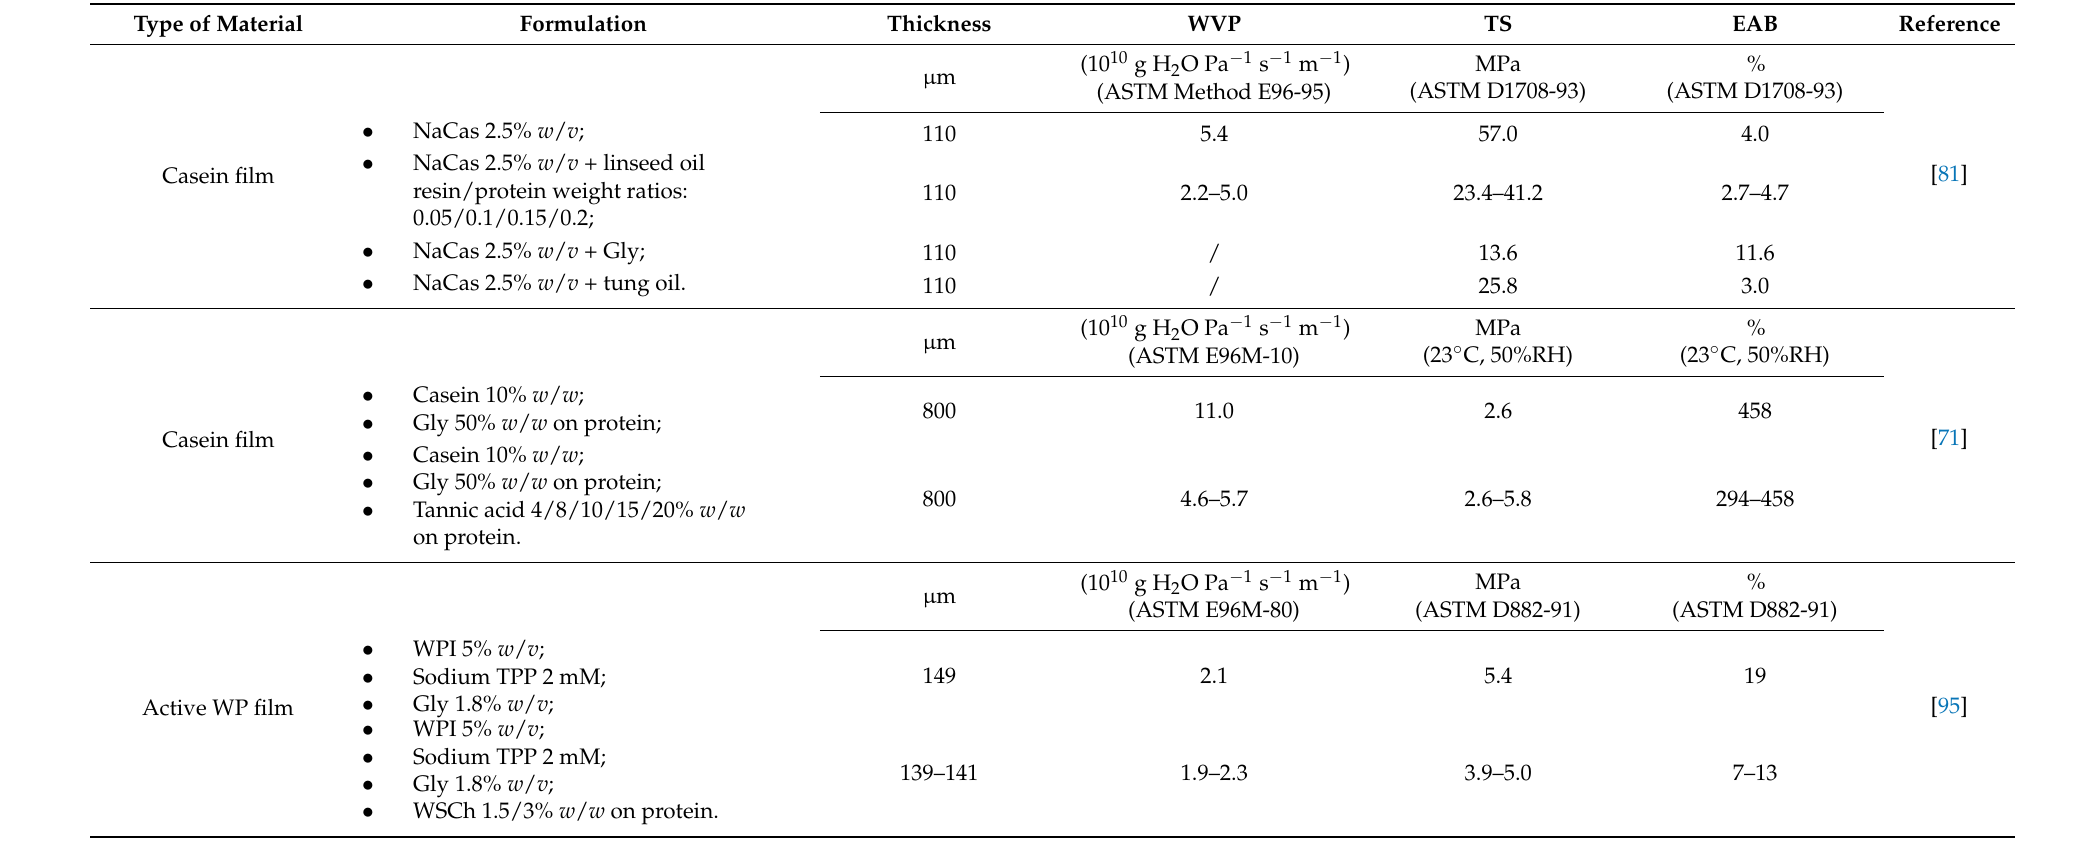
Table 4. Selected parameters of milk-protein-based films and